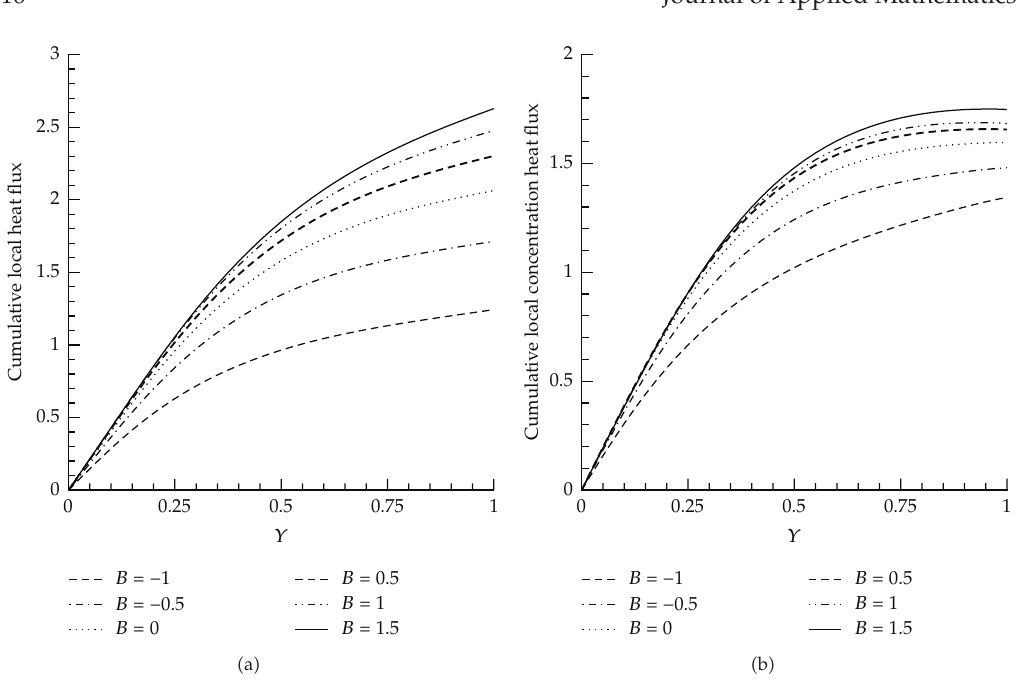
Figure 11: (cid:2) a (cid:3) Cumulative heat flux and (cid:2) b (cid:3) cumulative mass flux plots along the left vertical wall while fixing Le (cid:8) 1, D/H (cid:8) 0 . 1, a (cid:8) 0 . 1, Ra (cid:8) 100, S C (cid:8) 0 . 1 for di ff erent values of “ B ”.